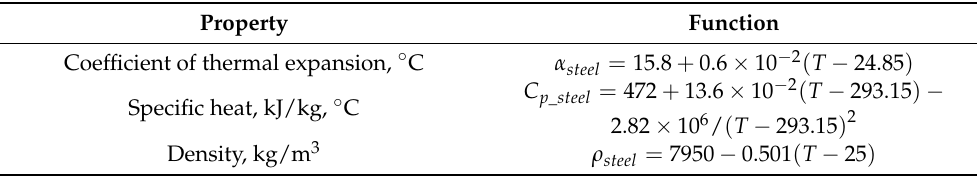
Table 2. Relations of tube material properties with